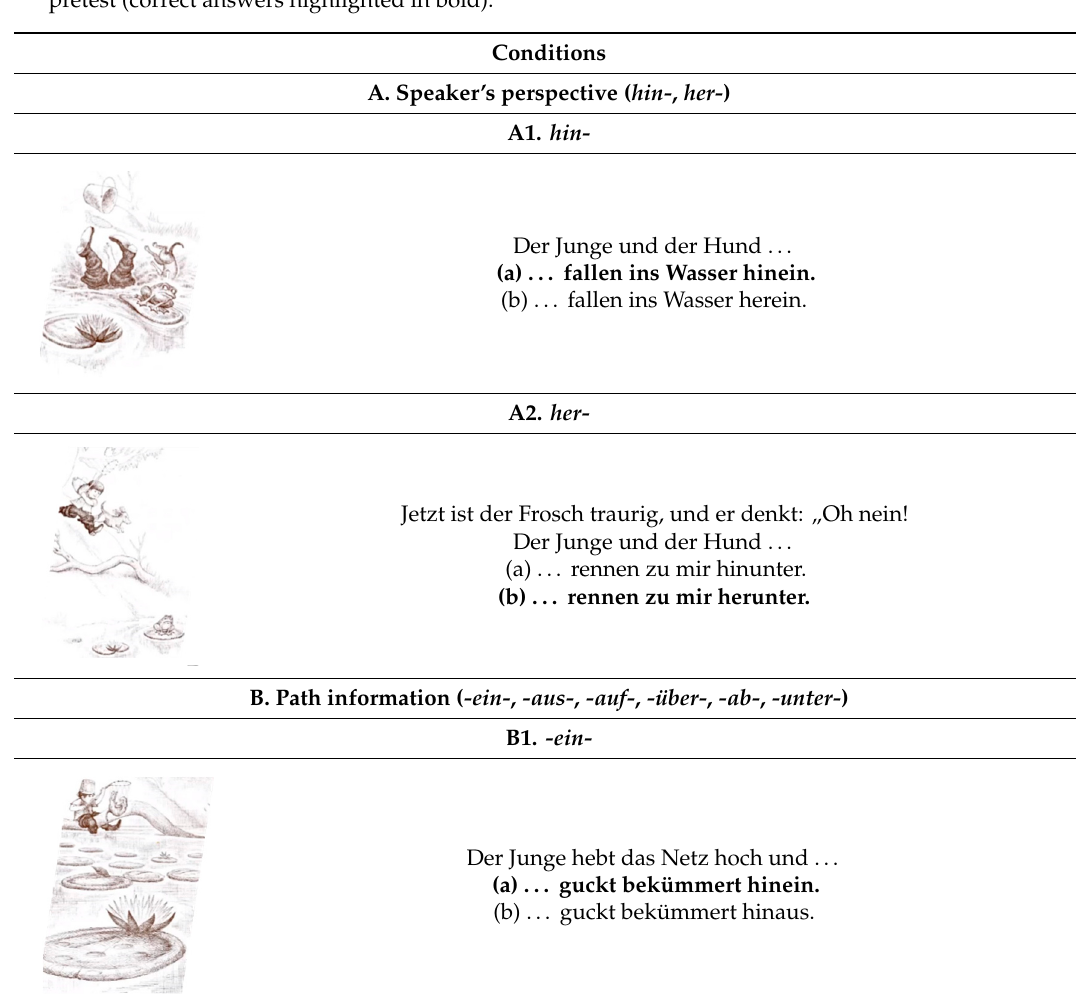
Table 1. List of conditions / subconditions of the binary-choice recognition task with examples from the pretest (correct answers highlighted in